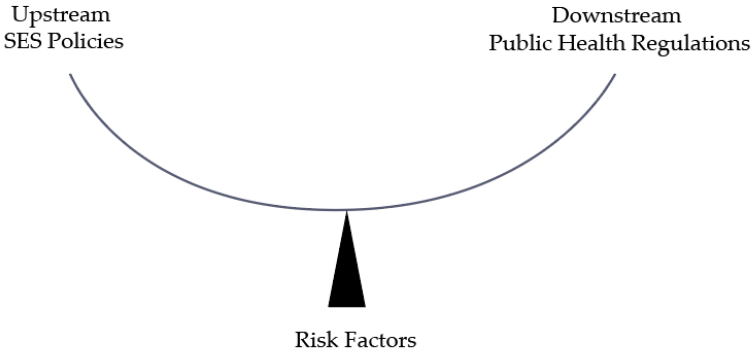
Figure 2. The balance between upstream policies, downstream regulations and risk factors.